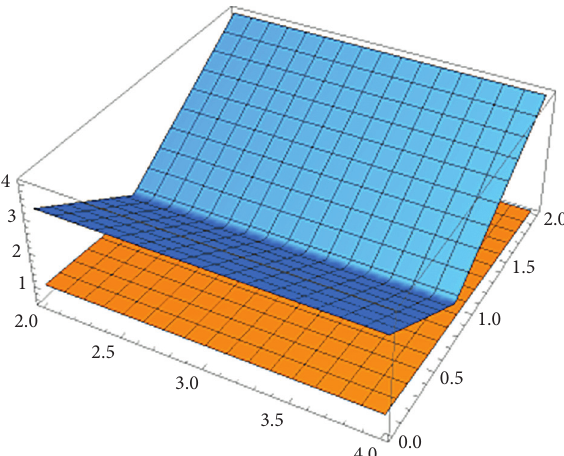
Figure 3: Dominance of right-hand side of equation (29) is visually checked for τ ∈ [ 2 , 4 ] , υ ∈ [ 0 , 2 ]